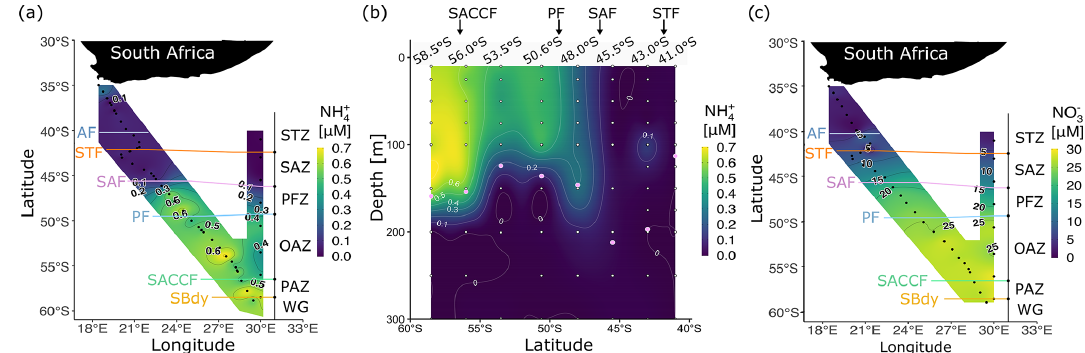
Figure 2. Concentrations of dissolved ammonium (NH + ) (a) at the surface for legs S and N and (b) with depth (0–300m) for leg N, and 4 (c) concentrations of nitrate (NO − ) at the surface for legs S and N. Pink circles in (b) show the mixed-layer depth at the CTD stations. 3 Abbreviations are as in Fig. 1. Figure produced using the package ggplot2 (Wickham, 2016).